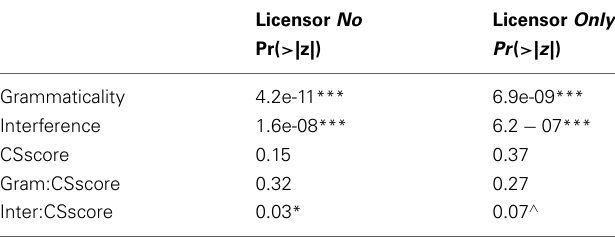
Table 4 | NPI licensing acceptance rate: fixed effects for two different NPI licensors.